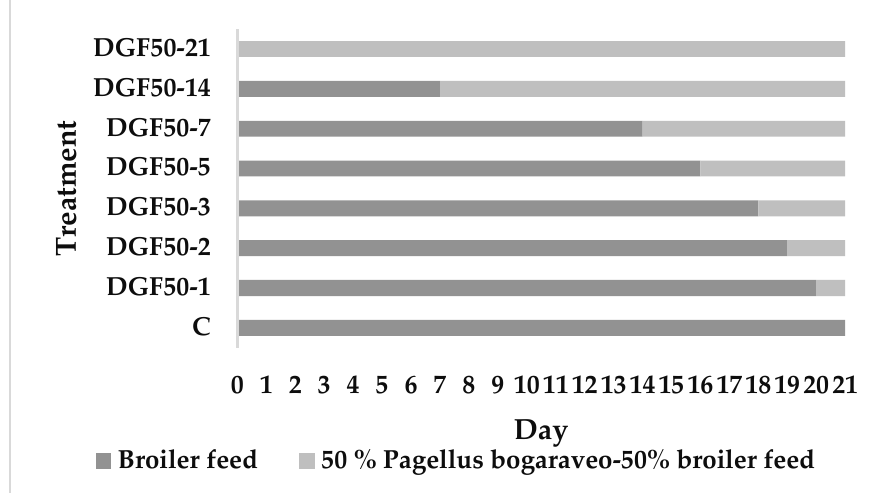
Figure 1. Intervals of substitution of control diet for DGF50 diet.